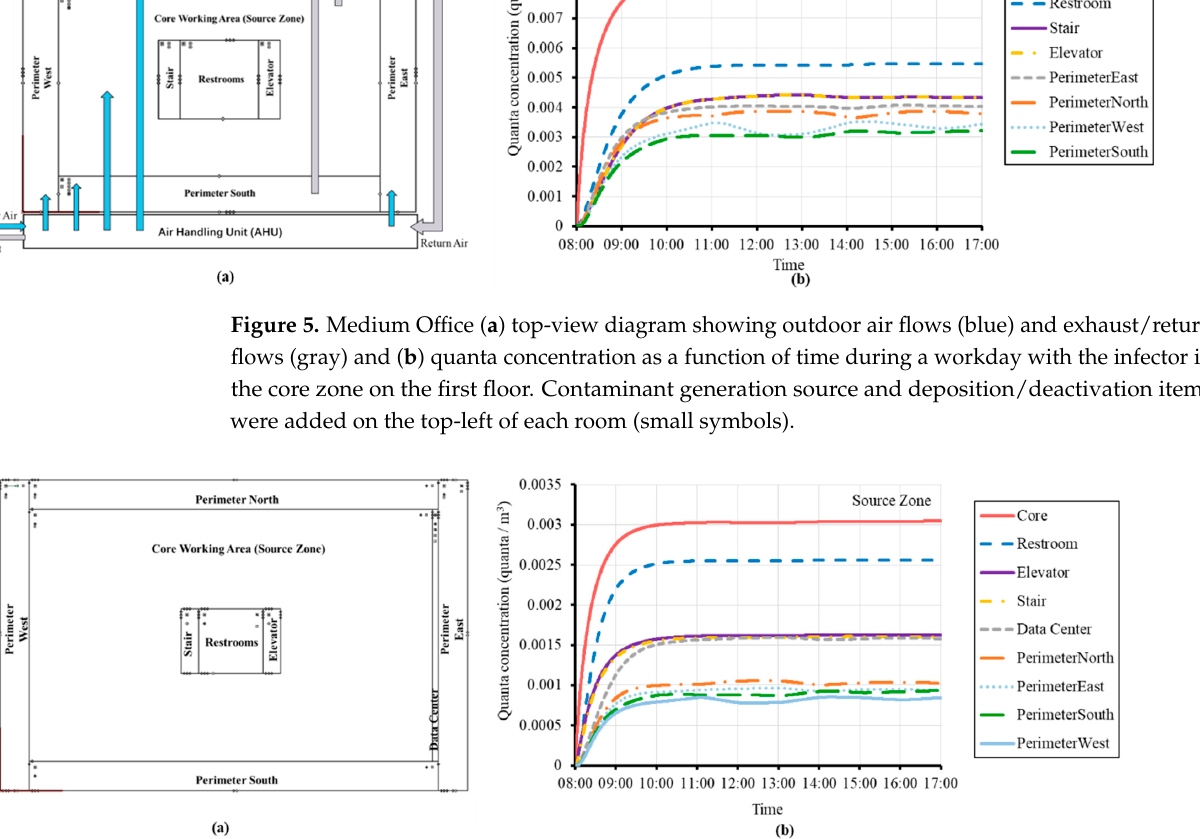
Figure 6. Large Office ( a ) top-view diagram of the Large Office 1 st floor and ( b ) quanta concentration as a function of time during a workday with the infector in the core zone on the first floor. Small icons in each room were contaminant generation source, deposition/deactivation items, and the supply/return of HVAC systems (small symbols).